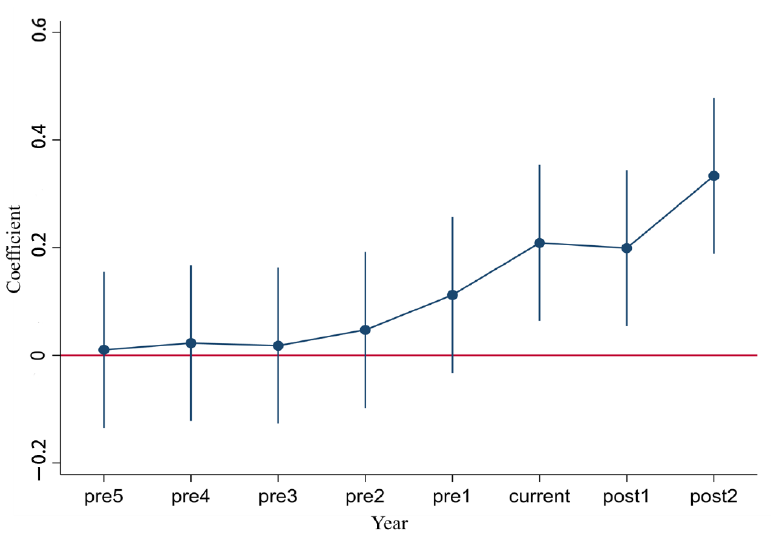
Figure 1. Parallel trend test results.